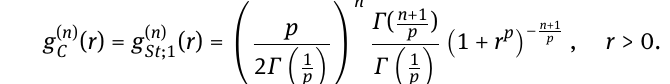
Table 4: q -domain quantiles of Φ